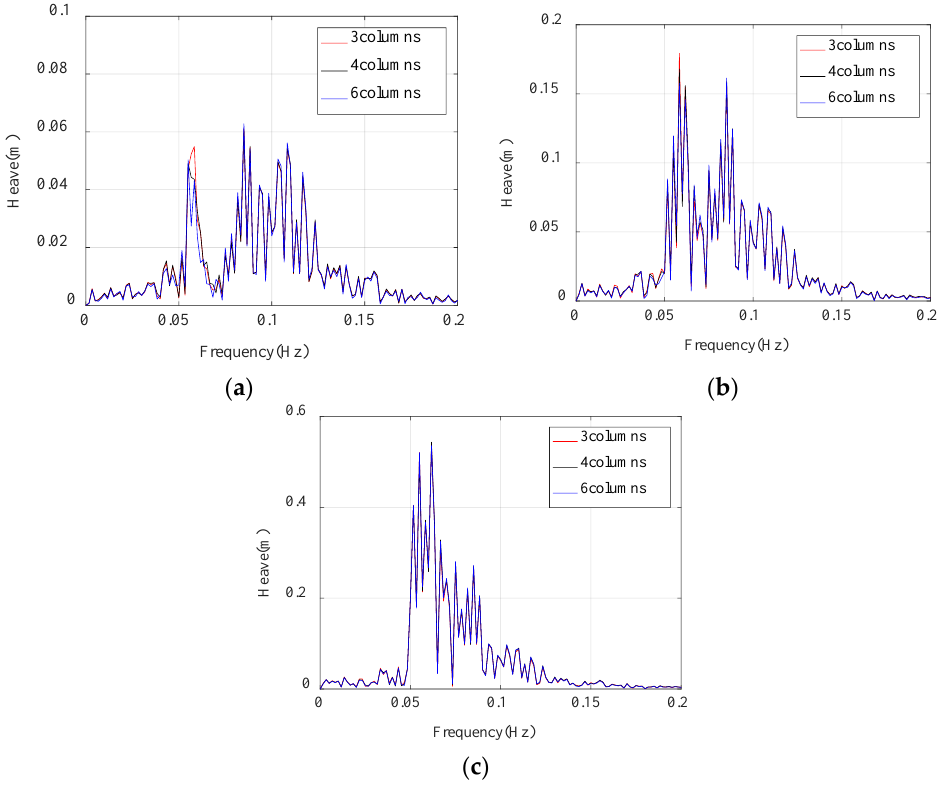
Figure 13. Heave response spectrum for the three platforms under wave loadings ( a ) LC4, ( b ) LC5, and ( c ) LC6.